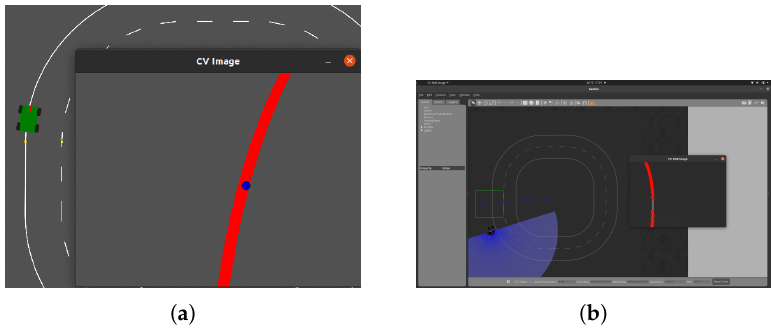
Figure 10. The above image shows the algorithm in action in 2 different simulators, namely SimpleSim and Gazebo. The circle is drawn at the centroid of the largest contour (the detected white line): ( a ) In SimpleSim simulator; ( b ) In Gazebo simulator.